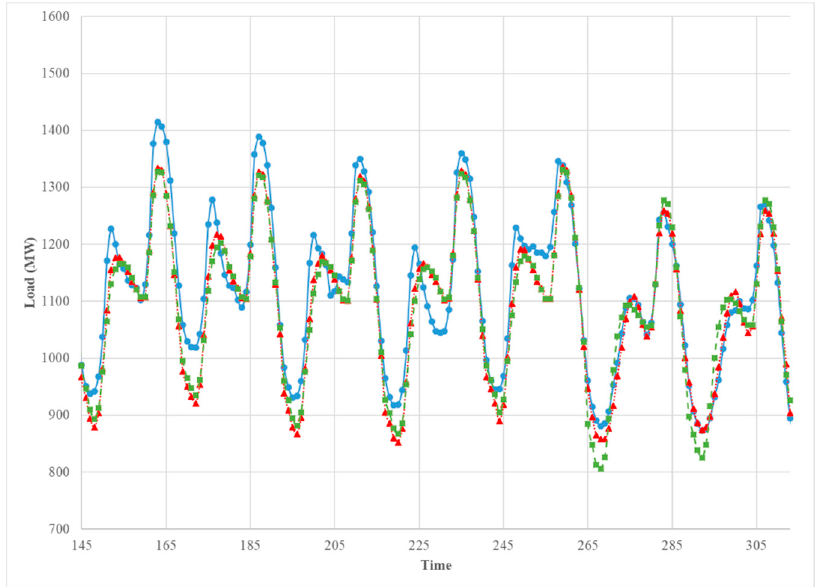
Figure 11. The comparison between the observed hourly load (blue solid), the predicted hourly load of Model 1 (red doted), and Model 2 (green dashed). 7 January 2013–13 January 2013. Energies 2019 , 12 , x FOR PEER REVIEW